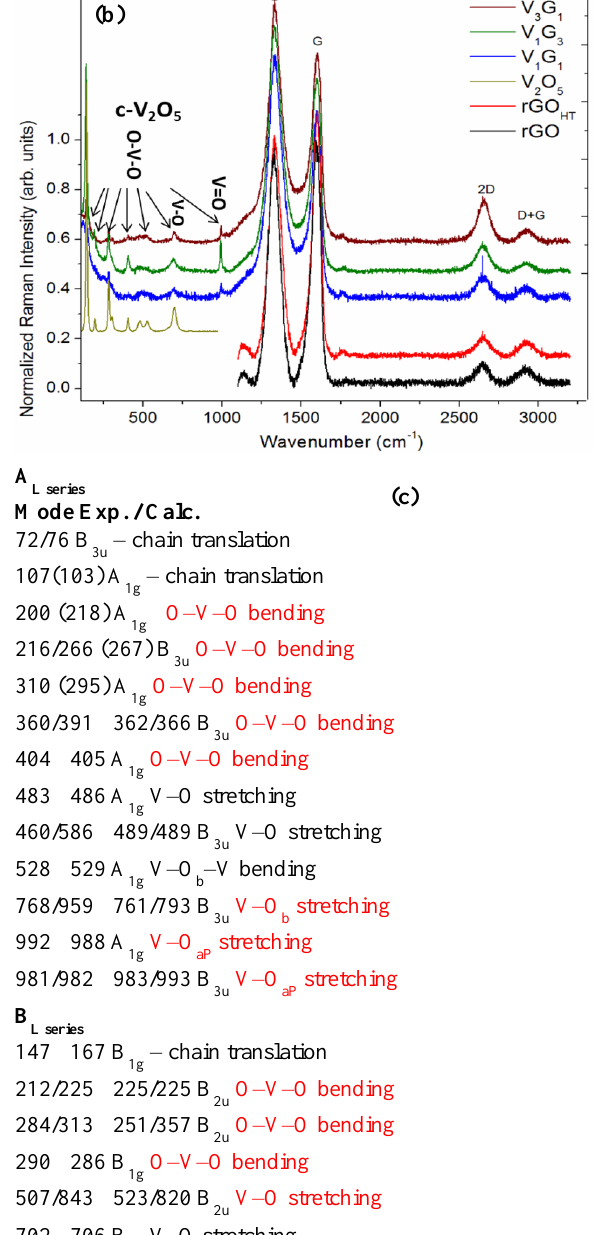
Figure 3. ( a ) X-ray diffractograms displaying characteristic peaks for graphene (002) and VNBs along with the substrate (Al 2 O 3 ). The narrow peaks exhibit higher crystallinity and their position is indicative of primarily the α -V 2 O 5 phase; ( b ) Micro-Raman spectra showing peaks associated with rGO and V 2 O 5 . The characteristic D, G, 2D and D + G combination bands are apparent along with V 2 O 5 nanobelts for composites; ( c ) Experimental and calculated Raman spectral bands for the V 2 O 5 lattice are also tabulated with group